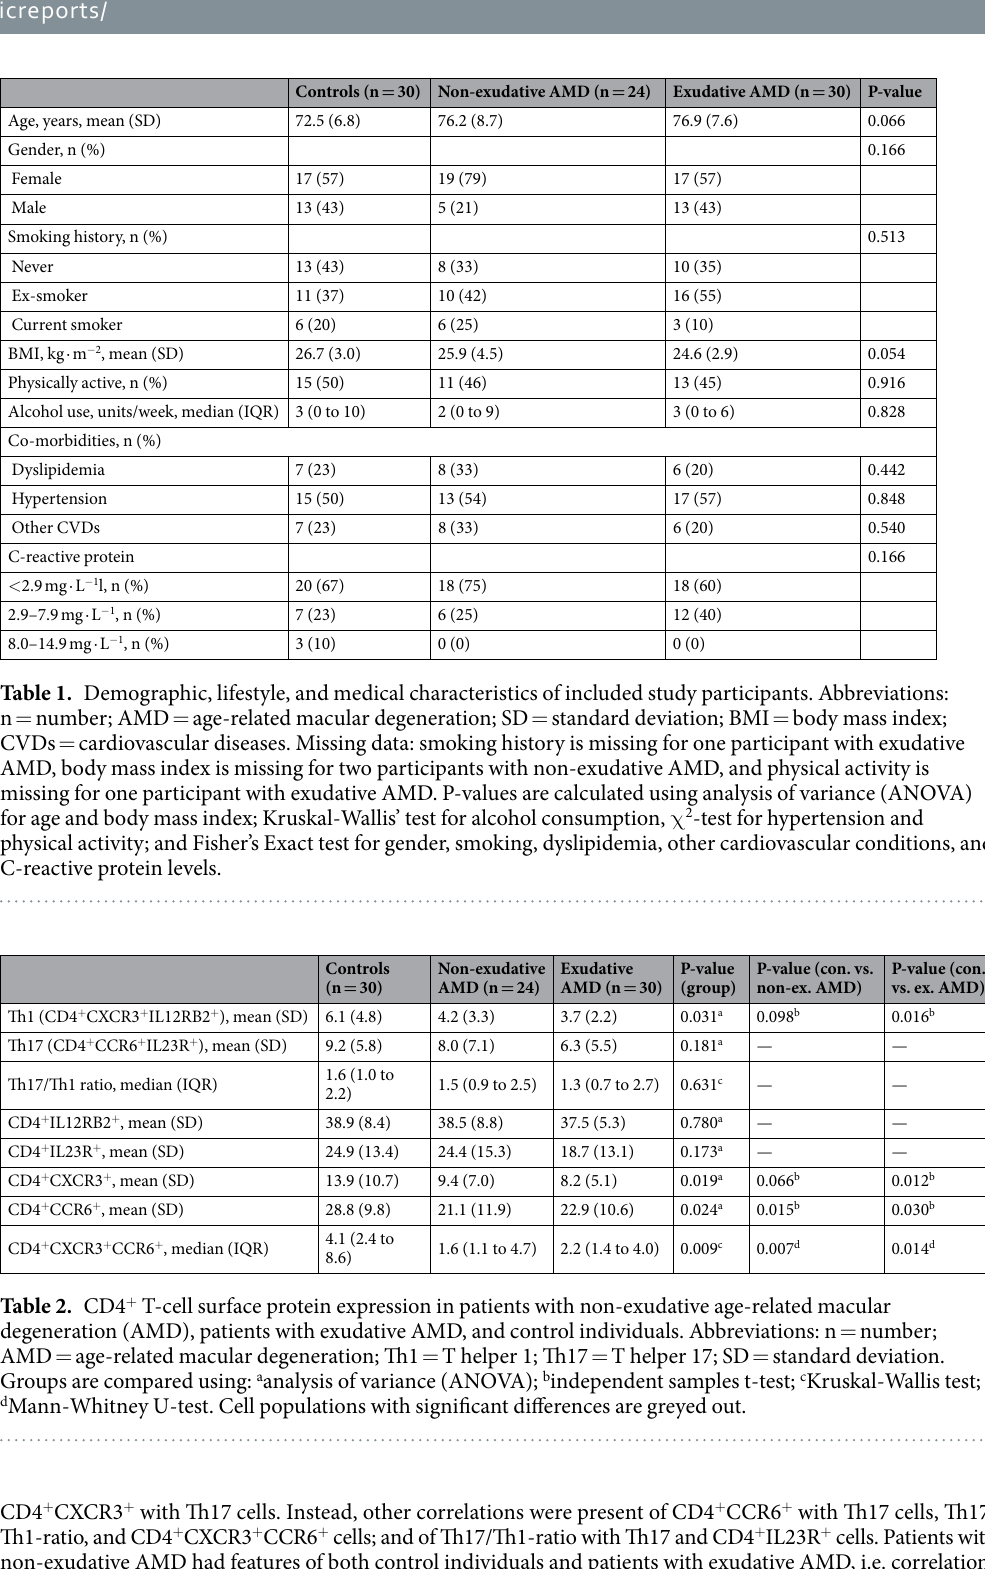
Table 2. CD4 + T-cell surface protein expression in patients with non-exudative age-related macular degeneration (AMD), patients with exudative AMD, and control individuals. Abbreviations: n = number; AMD = age-related macular degeneration; Th1 = T helper 1; Th17 = T helper 17; SD = standard deviation. Groups are compared using: a analysis of variance (ANOVA); b independent samples t-test; c Kruskal-Wallis test; d Mann-Whitney U-test. Cell populations with significant differences are greyed